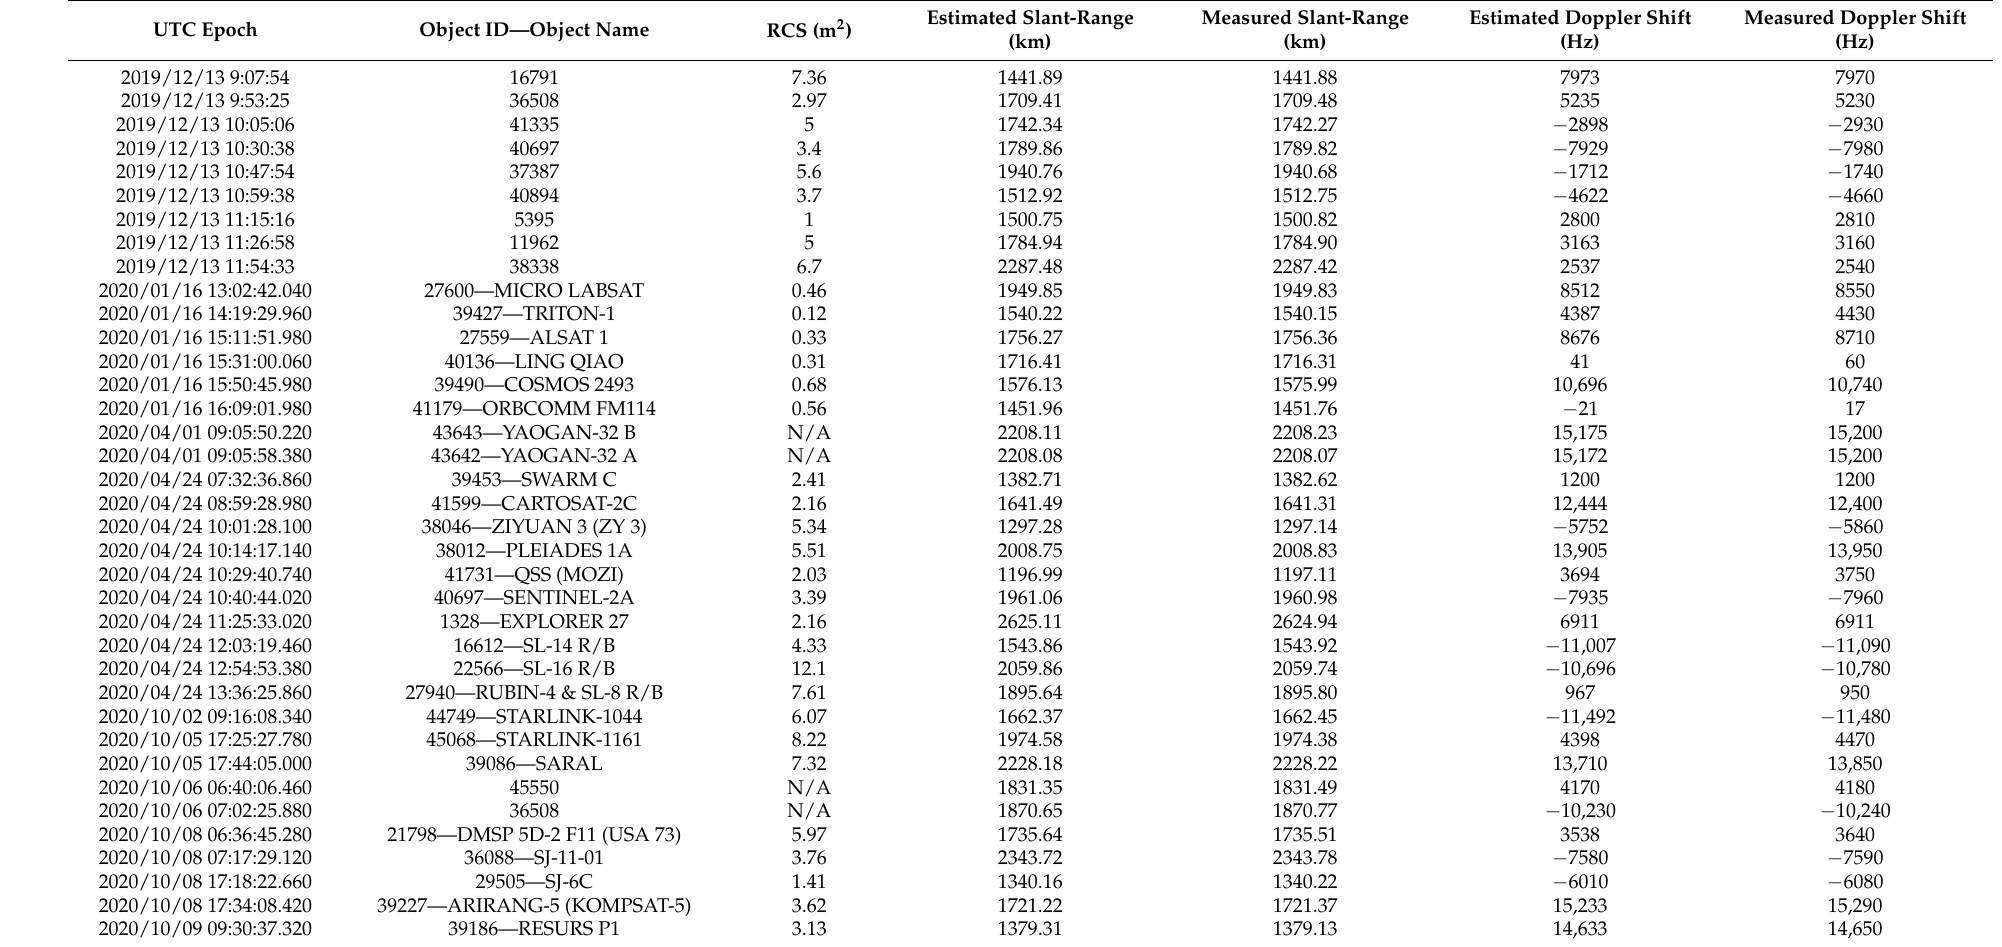
Table 2. Results of the measurement campaigns performed by the BIRALET radar between 13 December 2019 and 9 October 2020. For each object, the Coordinated Universal Time (UTC) epoch, the object ID and name, the Radar Cross Section (RCS), the estimated and measured values of the slant-range and the Doppler shift, are